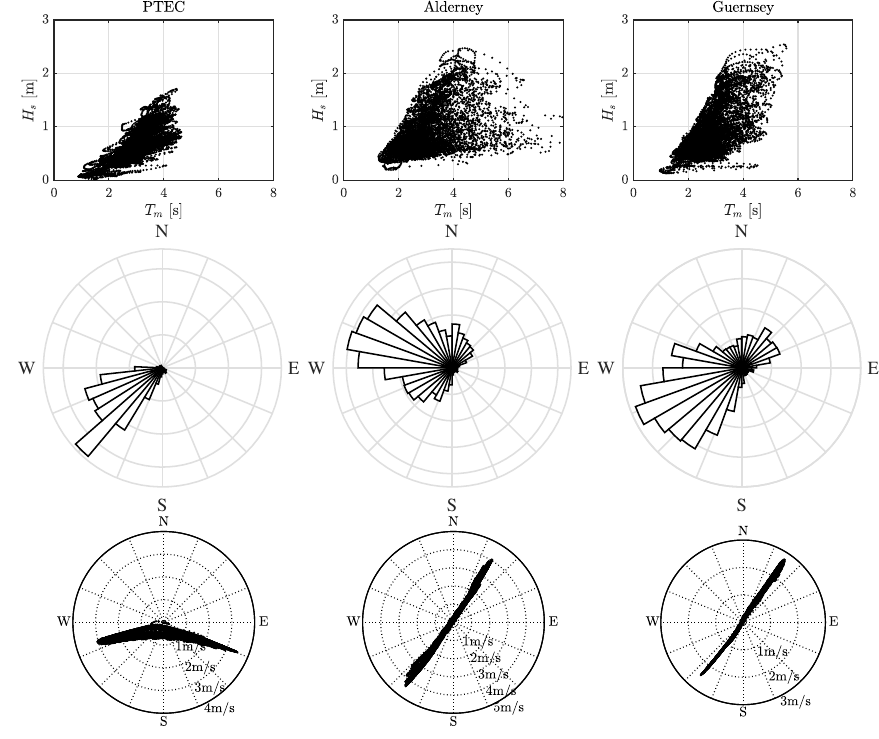
Figure 4. Summary of wave and current conditions: ( Top row ) scatter plots of significant wave height, H s , against mean absolute wave period (as measured in a fixed frame of reference); ( Middle row ) wave rose; and ( Bottom row ) current speed versus direction. Note that wave directions are ‘coming from’ and current directions are ‘going